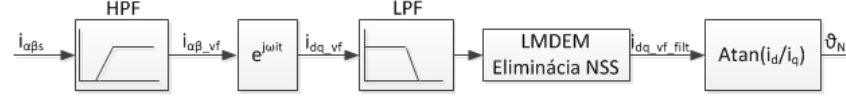
Figure 22. Block diagram of NSDR position estimation .